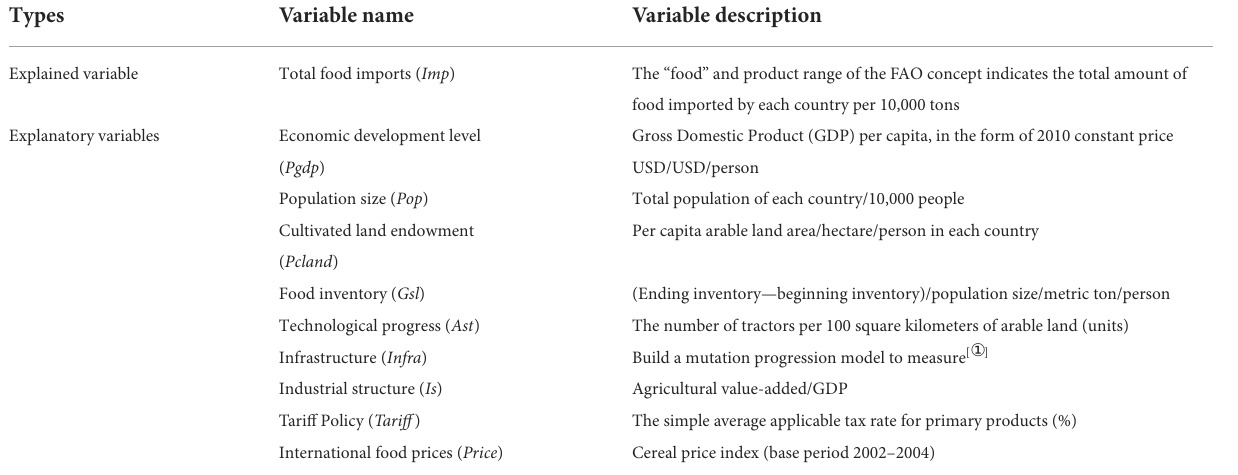
TABLE 1 Variable selection and